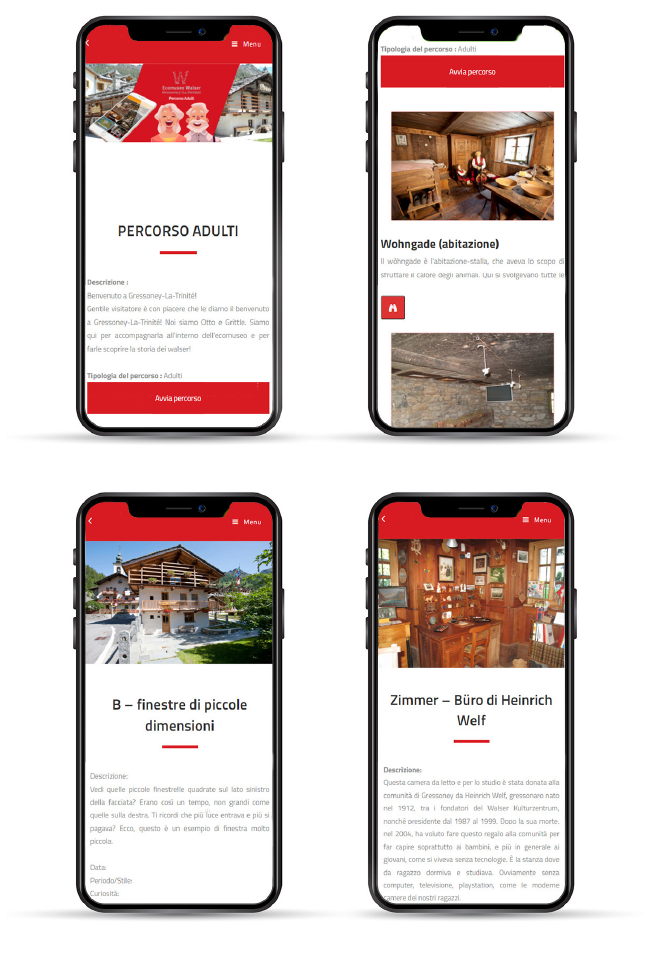
Fig. 6 The mobile application of Ecomuseo